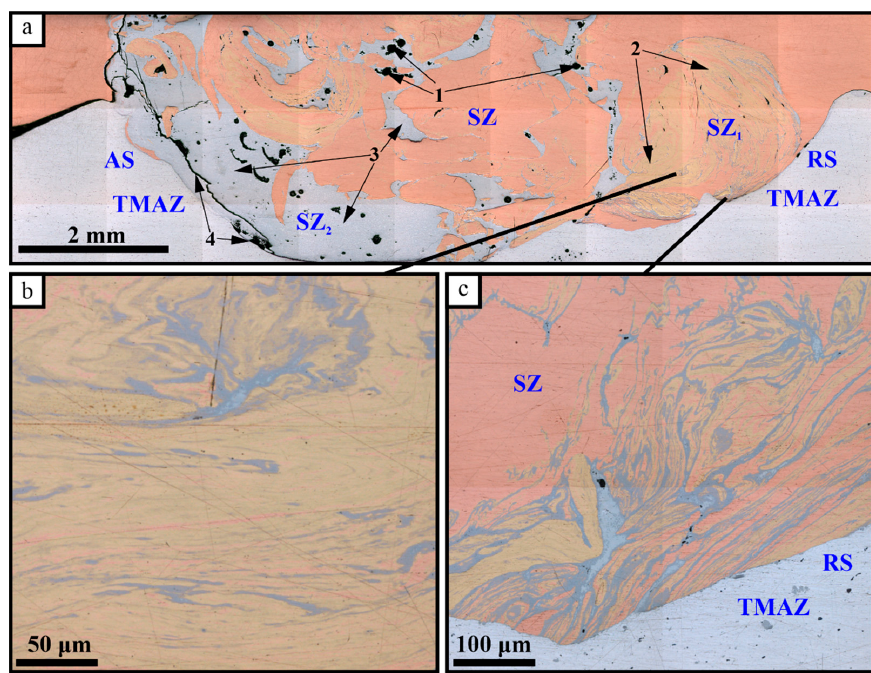
Figure 2. The FSPed SZ cross-sectional zones and Cu-Al intermixed areas: 1—defects; 2—solid solution (SS) areas; 3—IMC areas; 4—cracking at the advancing side; AS—advancing side; RS—retreating side; ( a ) the SZ macrostructure; ( b ) alternating SS and IMC layers; ( c )—aluminum inflow pattern.